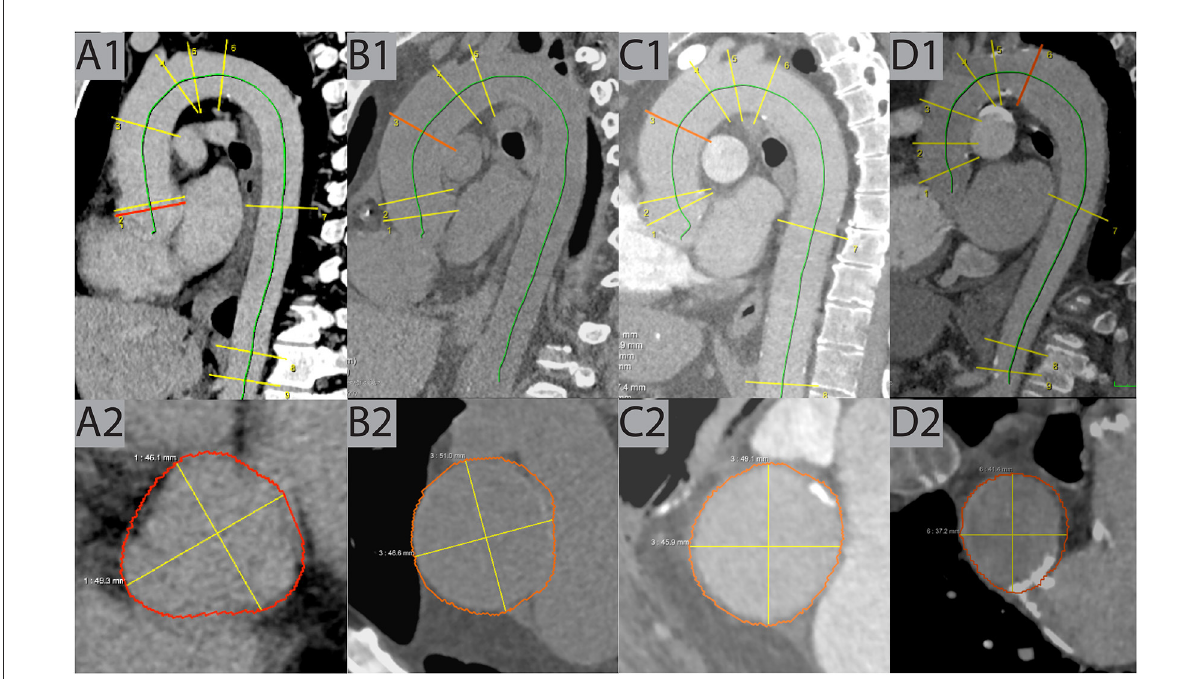
FIGURE3 Examples of true positive cases. (A) This case shows dilatation of the AS (49mm) in venous phase CT of a 57-year-old male patient detected by AIRad. (B) In this non-CE exam, dilatation of the AA (51mm) was found in a 54-year-old male patient. (C) Similar to B but in pulmonary-arterial phase, AA dilatation (49mm) in a 66-year-old male was revealed by AIRad. (D) Dilatation of the DA (41mm) was identified by AIRad in a pulmonary-arterial phase CT of a 56-year-old female patient. AA, ascending aorta; AS, aortic sinus; CE, contrast enhanced; DA, distal arch.